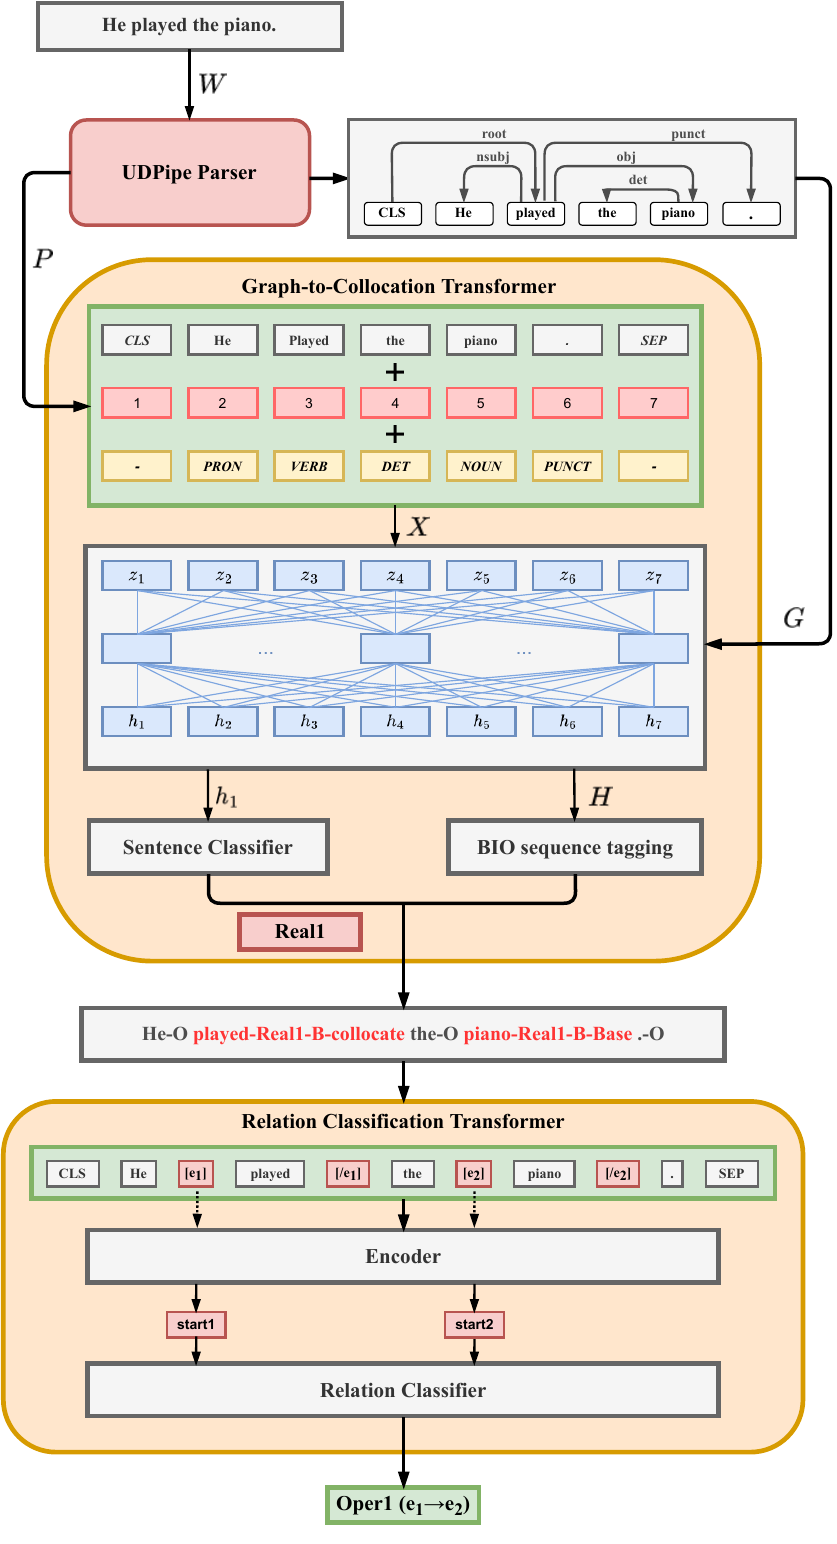
Figure 1. Relation-Based Graph-to-Collocation Transformer. Enc () computes the contextualized vector embeddings H as the sum of pre-trained to- ken embeddings of BERT, position embeddings, and PoS tag embeddings using a modified version of the Transformer attention mechanism to inject the syntactic dependency infor- mation. In each Transformer layer, given Z n = ( z 1 , z 2 , . . . , z T ) as the output